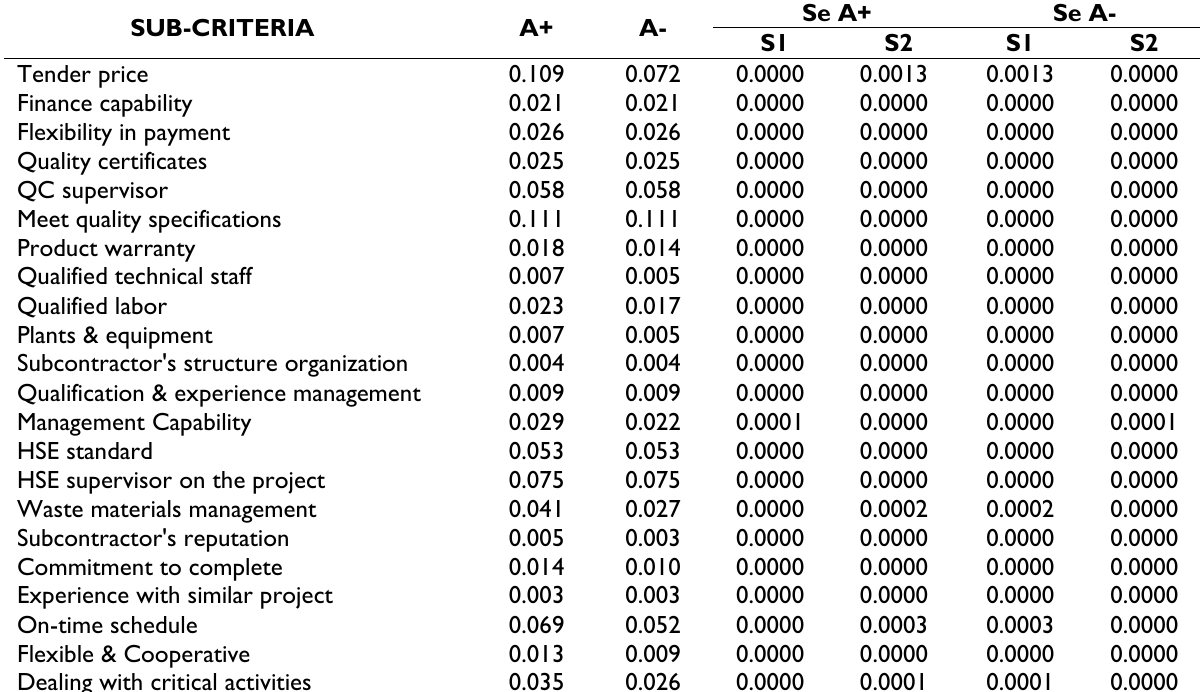
Table 5. Separation of positive ideal (Se A+) and negative model (Se